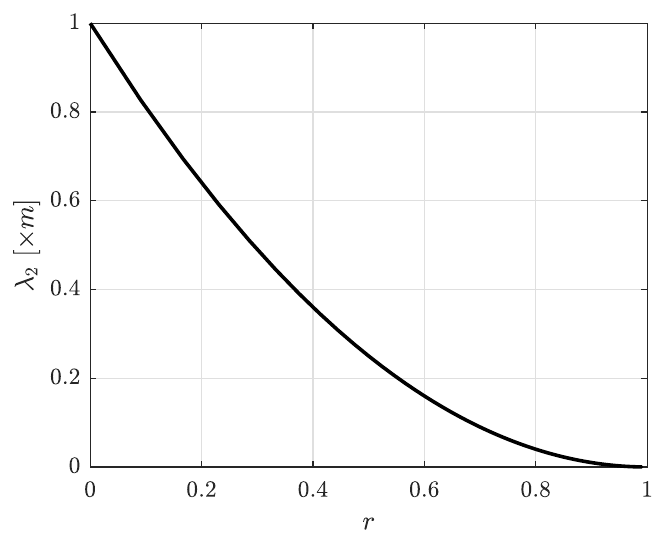
Figure 4. CI of a rigid body varying